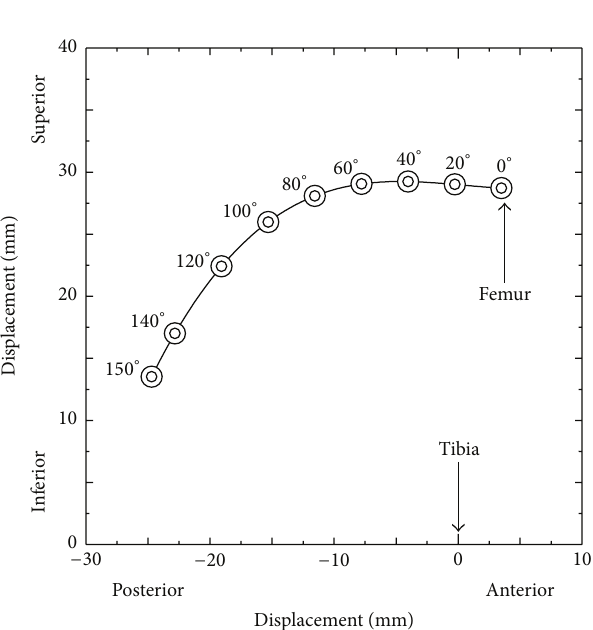
Figure 2: Trajectory of the center of the femur in the sagittal plane for a Japanese male (original data are obtained from [16]).